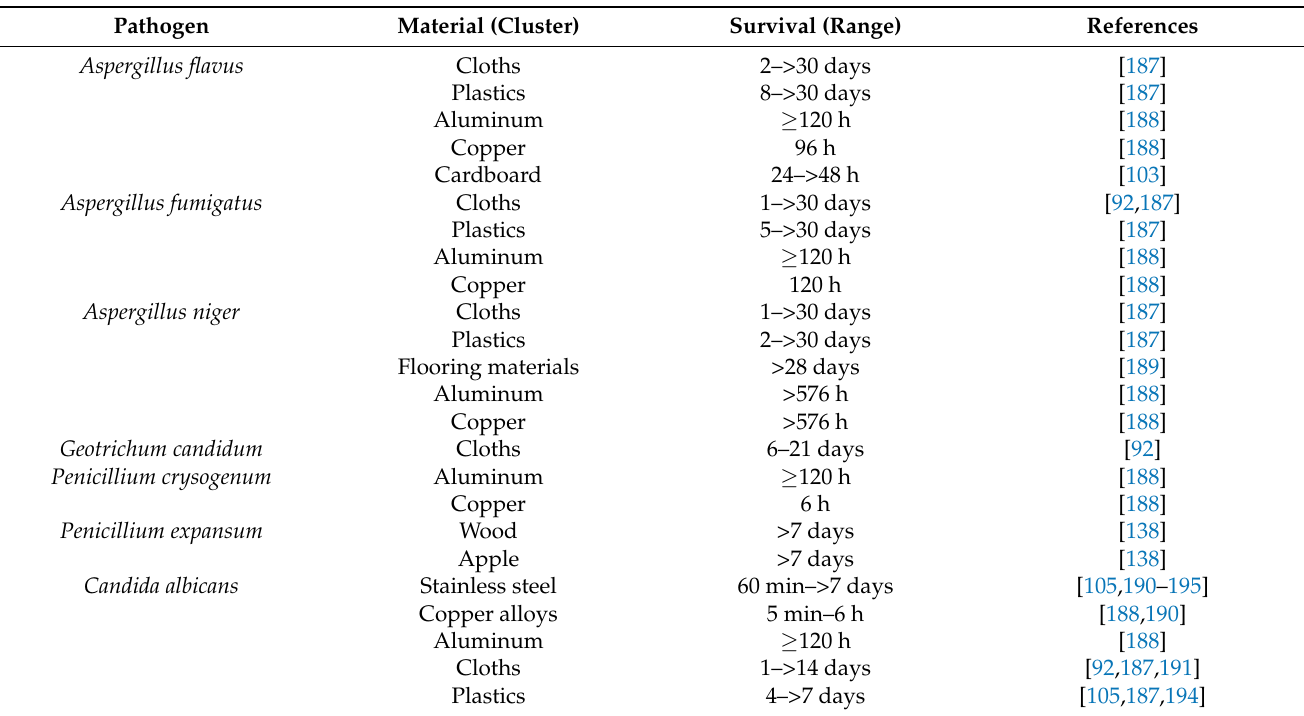
Table 6. Survival of fungi on inanimate surfaces. Survival duration is given in